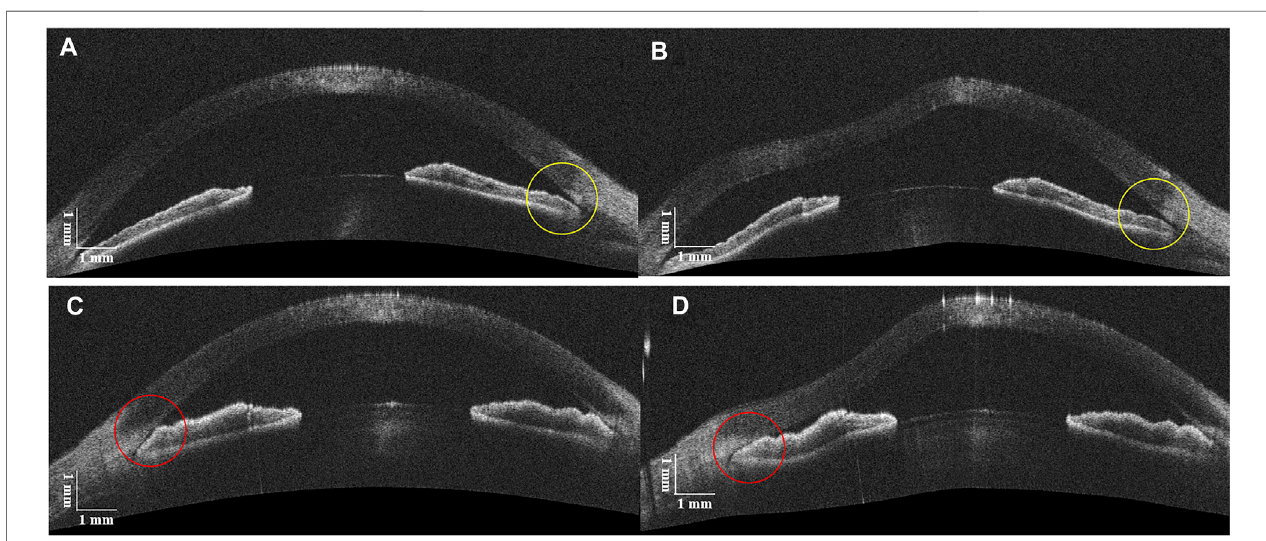
FIGURE 5 | DAS-OCT images before and after the air puff. (A) , ACA with NPAS before the air puff; (B) , ACA with NPAS after the air puff (yellow circles). (C) , ACA with PAS before the air puff; (D) , ACA with PAS after the air puff (red circles).